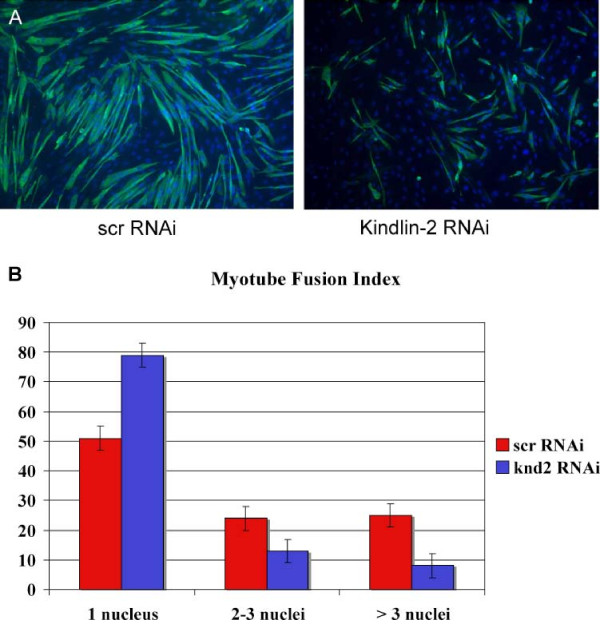
Myoblast fusion and kindlin-2 knockdown. A. C2C12 cells transfected with scrambled (scr) or kindlin-2 RNAi, incubated in differentiation media for 4 days, and then immunostained with anti-myosin heavy chain. Note that most MHC positive myoblasts treated with kindlin-2 RNAi do not form elongated, multinucleated myotubes. B. Myotube Fusion Index (MFI). The MFI was calculated using immunostained cells as in (A). The number of nuclei (labeled with DAPI) were counted in each MHC positive cell. There were significantly fewer fused myotubes in kindlin-2 knockdown cells. Results were (scrambled vs. kindlin-2): 1 nuclei 51.1+/-2.9% vs. 75.6+/-2.6% (p = 0.0001); 2–3 nuclei 25.5+/-2.6% vs. 15.4+/-1.0% (p = 0.0036); >3 nuclei 23.4+/-1.3% vs. 8.9+/-1.6% (p < 0.0001). Counts were obtained from 5 independent trials/transfections, and at least 250 cells from each condition were counted per trial.